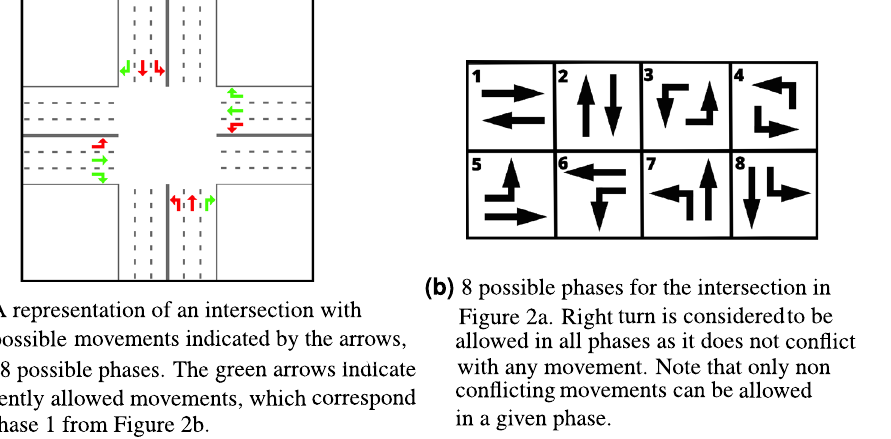
Figure 2. A representation of an intersection with 12 possible movements indicated by the arrows, and 8 possible phases. The green arrows indicate currently allowed movements, which correspond to phase 1 from Fig. 2b. 8 possible phases for the intersection in Fig. 2a. Right turn is considered to be allowed in all phases as it does not conflict with any movement. Note that only non conflicting movements can be allowed in a given